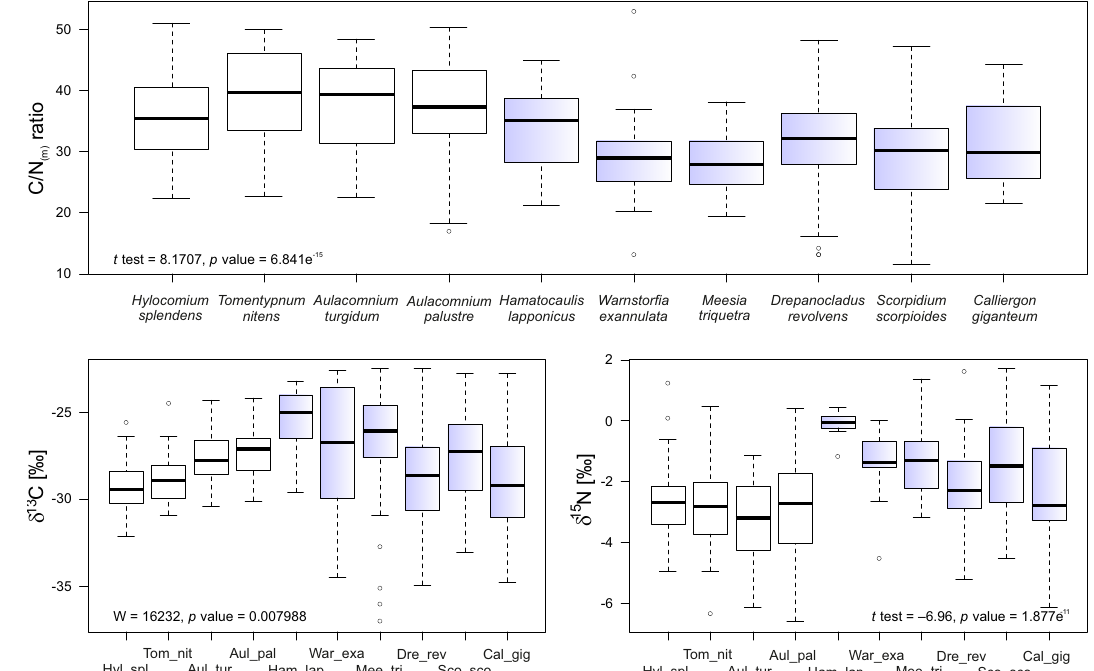
Figure 2. C / N ratios and δ 13 C and δ 15 N values of the 10 moss taxa studied. White box plots are the xero-mesophilic group and box plots shaded in blue are the meso-hygrophilic group. A t test was done to distinguish the signals between the two habitat